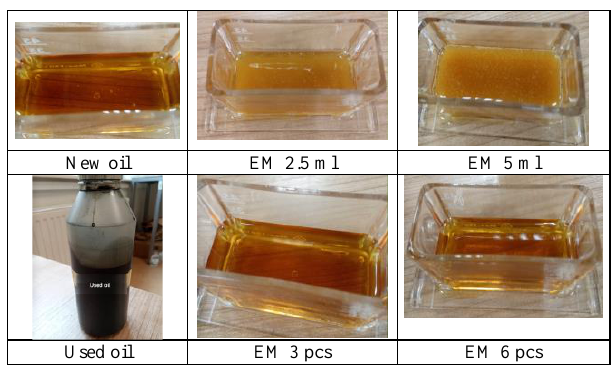
Fig. 2. Fresh oil, with the addition of effective microorganisms in liquid form and ceramic tubes and used oil